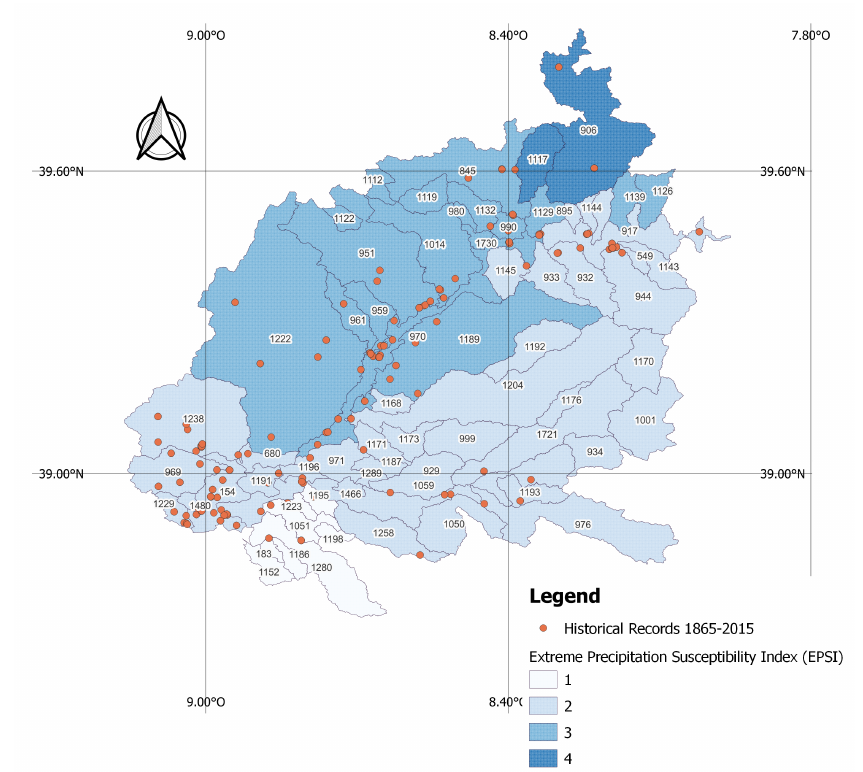
Figure 3. Data collection for the likelihood of flood occurrence: EPSI and historical records. Large values of EPSI indicate larger